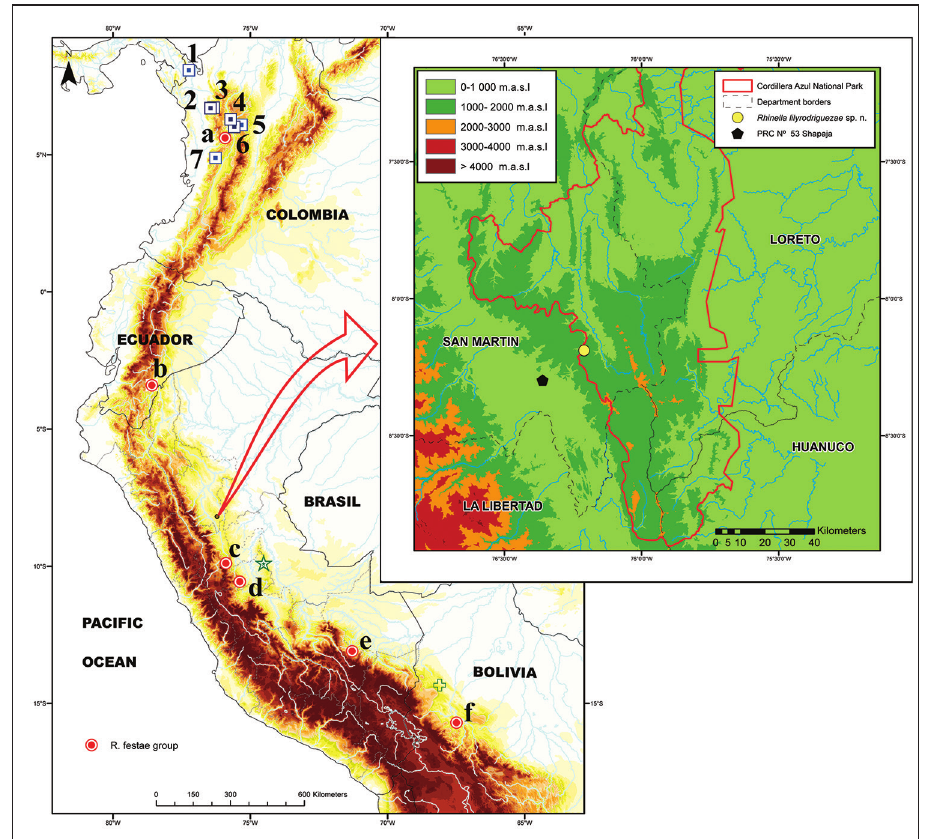
Figure 1. Map showing the type localities of Rhinella lilyrodriguezae sp. n. (  , yellow), selected spe- cies of the former genus Rhamphophryne (  , blue; with numbers 1 R. acrolopha 2 R. tenrec 3 R. lindae 4 R. nicefori 5 R. rostrata 6 R. ruizi 7 R. paraguas ), species of the Rhinella festae group (  , red; with letters a R. macrorhina b R. festae c R. chavin d R. yanachaga e R. manu , f: Rhinella cf. nesiotes ) and type locali- ties of Rhinella nesiotes (  , green star) and Rhinella tacana (  , cross, green). Abbreviation PRC: Park Rangers